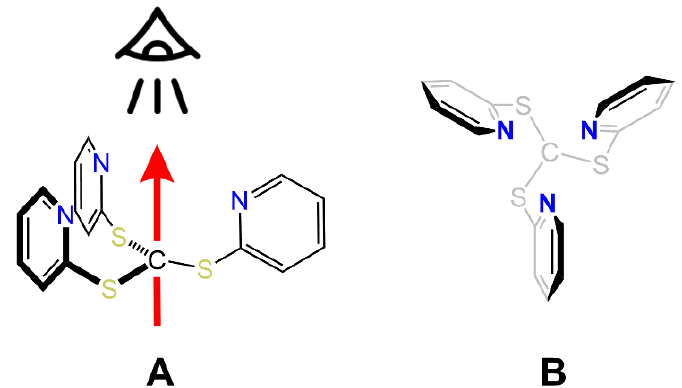
Figure 7. Coordination axis ( A ) and viewpoint ( A , B ) employed for the %V bur calculation of Tptm and representation of associated steric maps.